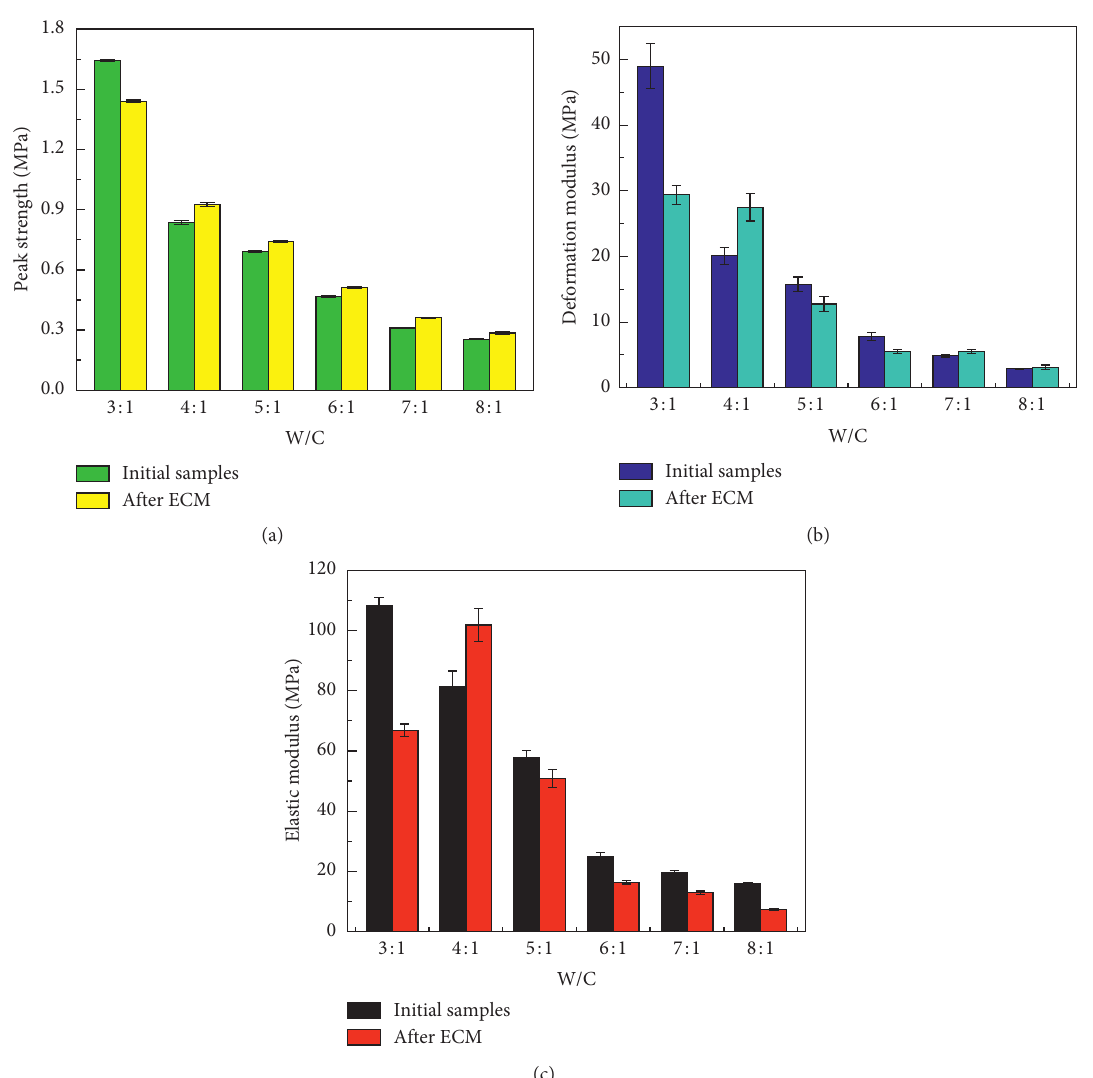
Figure 11: The change of elastic module of samples with different W / C after electrochemical